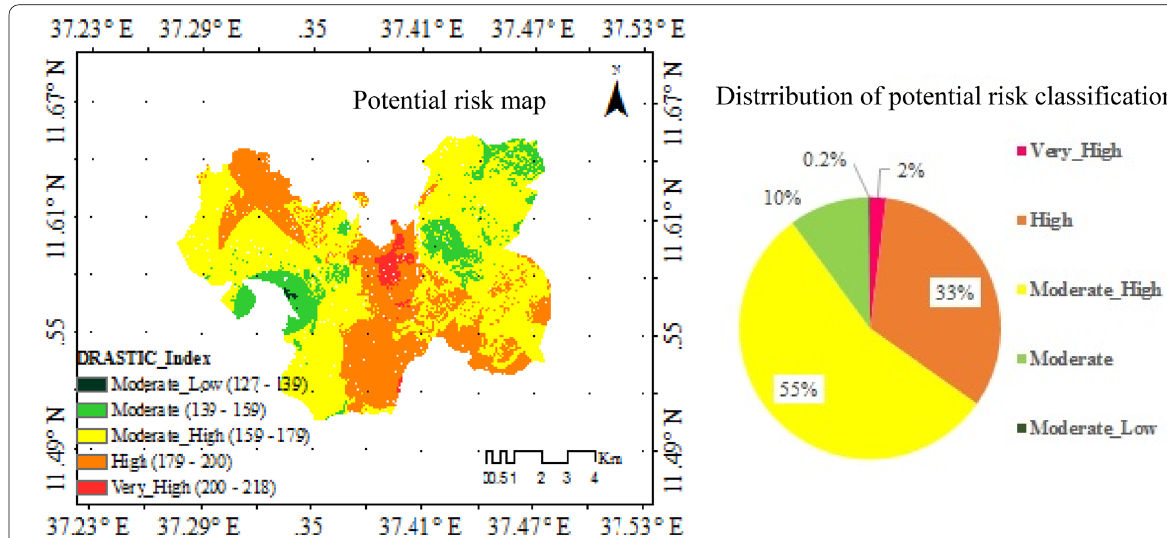
Fig. 5 Potential risk map (left) and Percent Area Distribution (right)